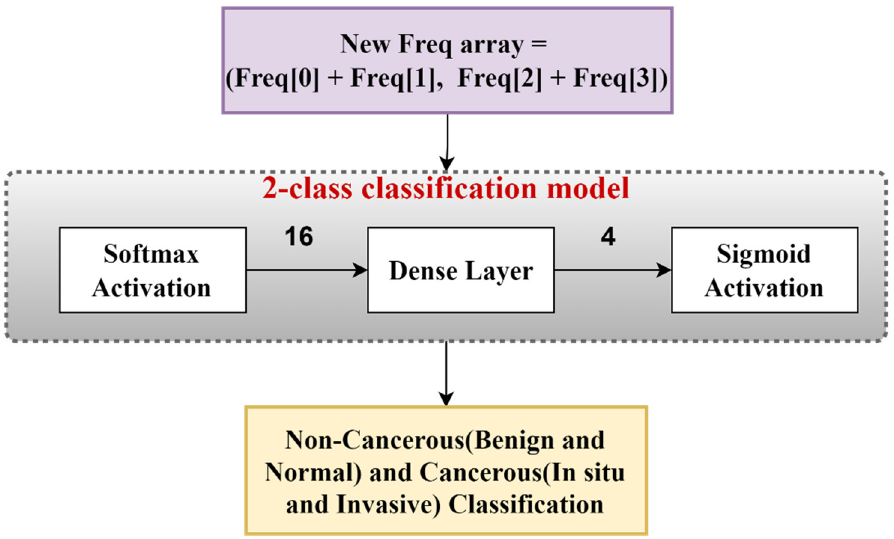
Figure 8. The 2-class image classification model that takes in the frequency array and uses it for the image classification into cancerous or non-cancerous images.